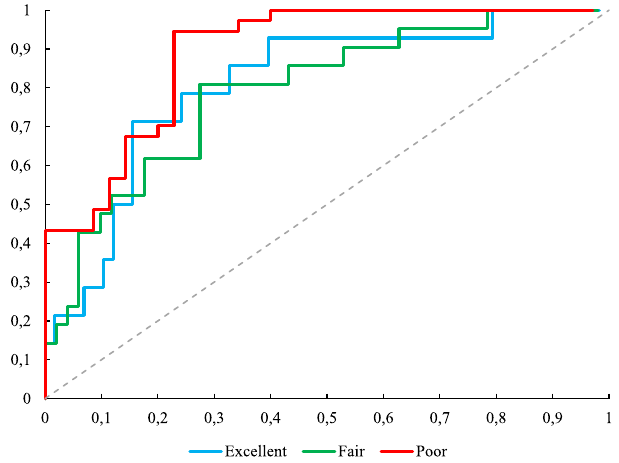
Figure 2. ROC curve for the ANN test data with architecture 1.